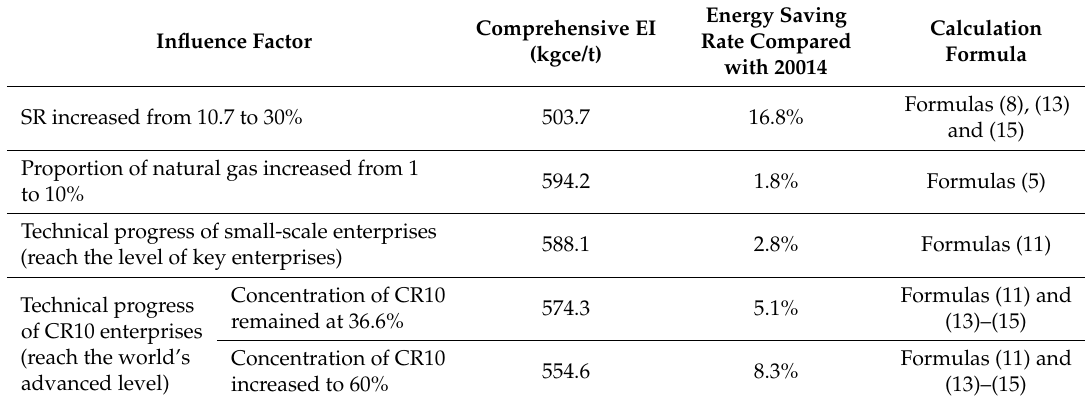
Table 6. Energy saving potential of each main influence